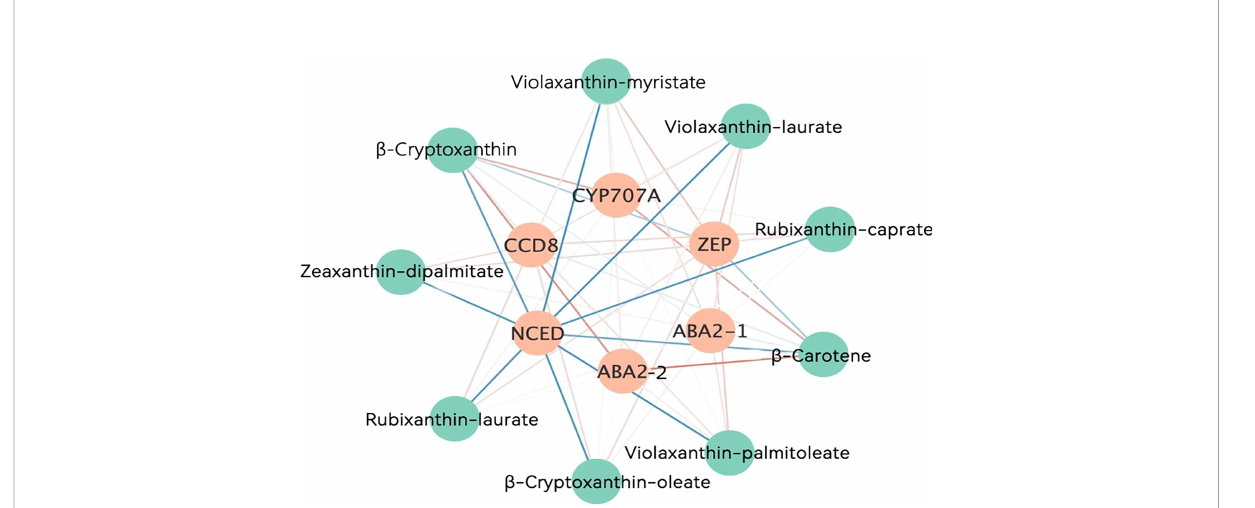
FIGURE 7 Correlation analysis between DEGs and core differential carotenoid metabolites. The blue lines represent negative correlations. The yellow lines represent positive correlations. The darker the color, the higher the correlation coef fi cient.